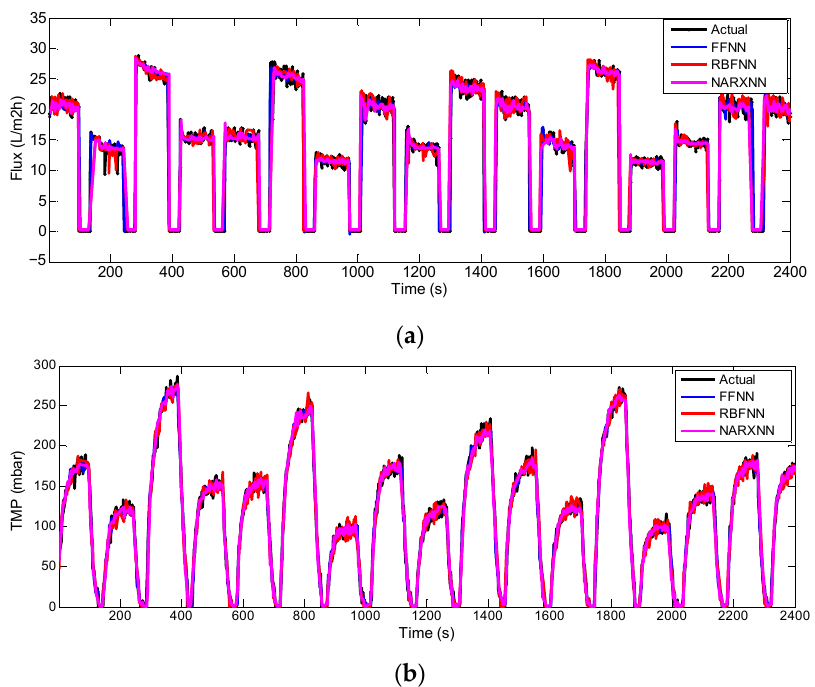
Figure 13. Training models for ( a ) flux; ( b ) trans-membrane pressure (TMP).